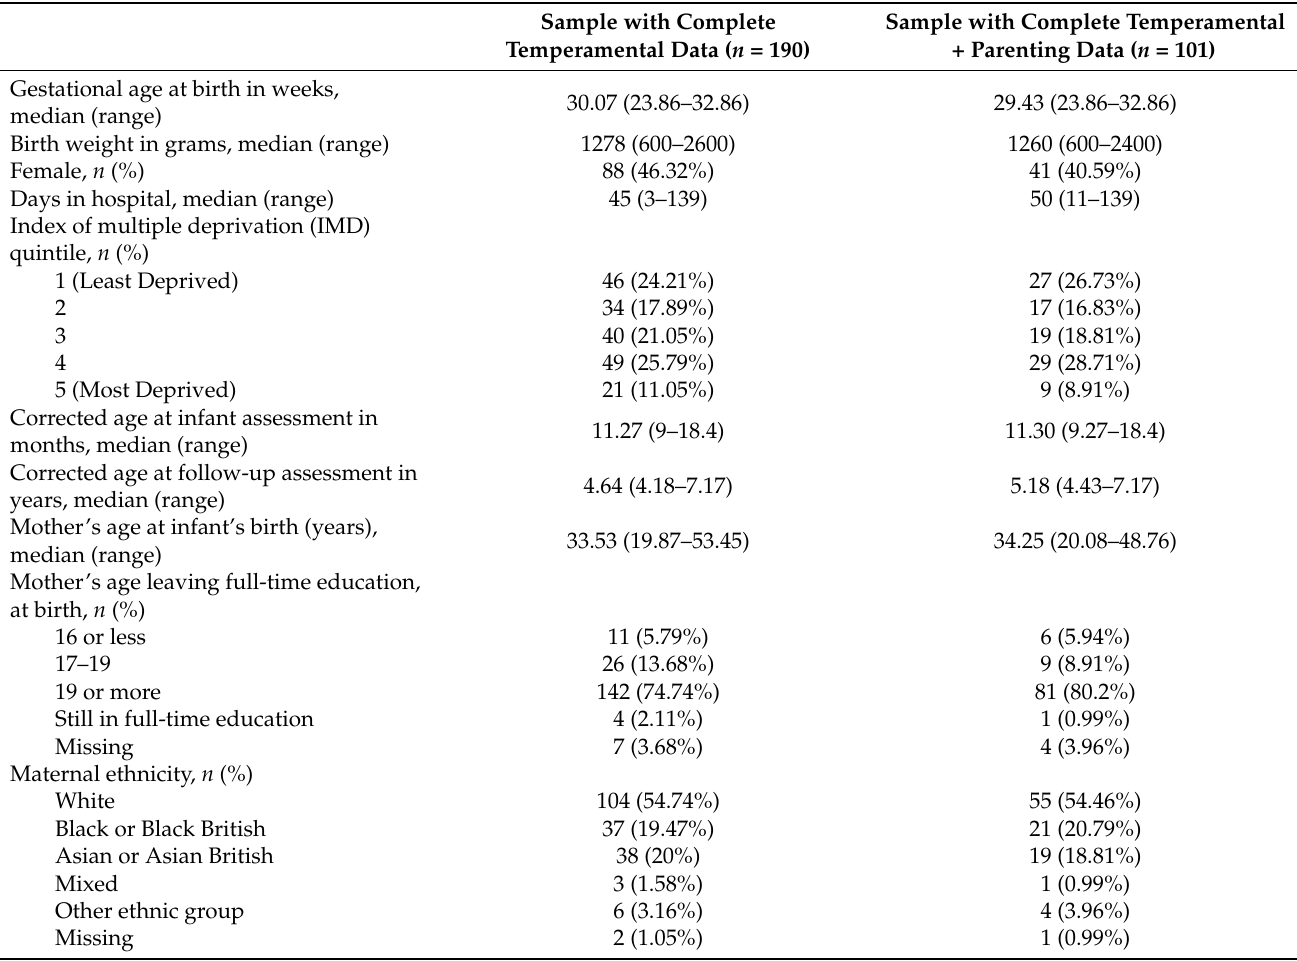
Table 1. Study participants’ socio-demographic